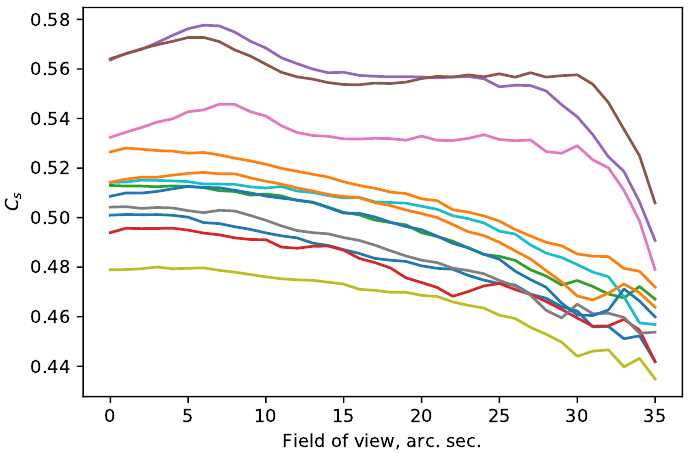
Figure 7. The examples of the calculated functions to determine the vertical structure of the atmospheric turbulence. Subaperture diameter is equal to 0.075